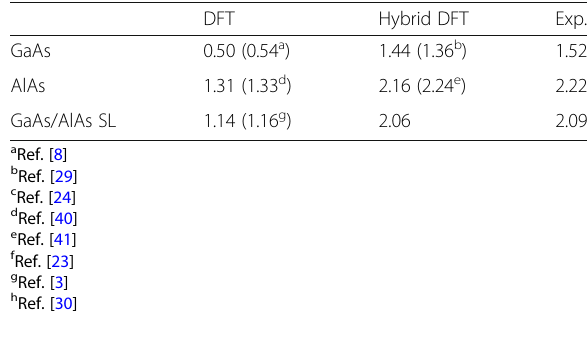
Table 4 The calculated band gap (eV) for bulk GaAs, AlAs, and GaAs/AlAs superlattice